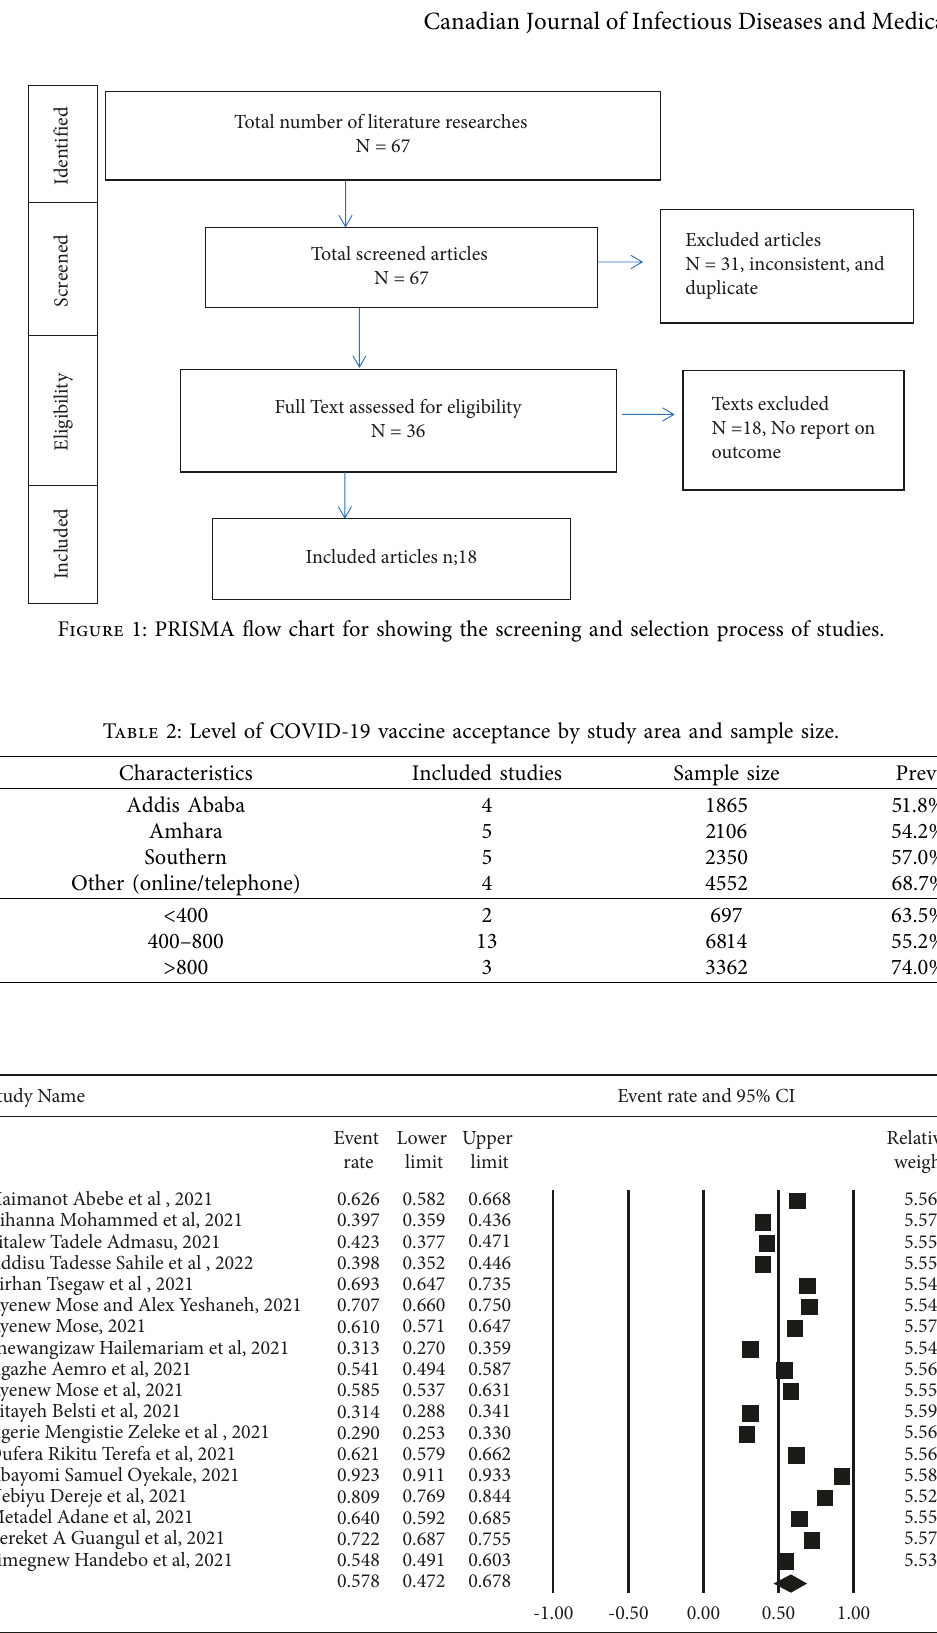
Figure 2: Forest plot for the pooled prevalence of COVID-19 vaccine acceptance.